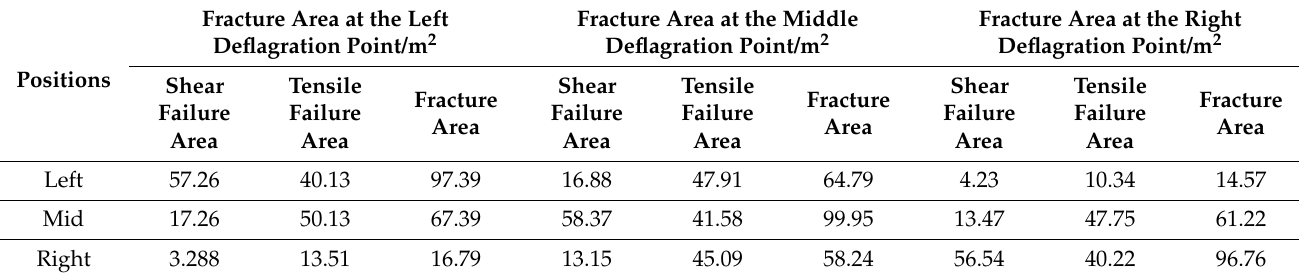
Table 4. Fracture quantitative characterization at different deflagration